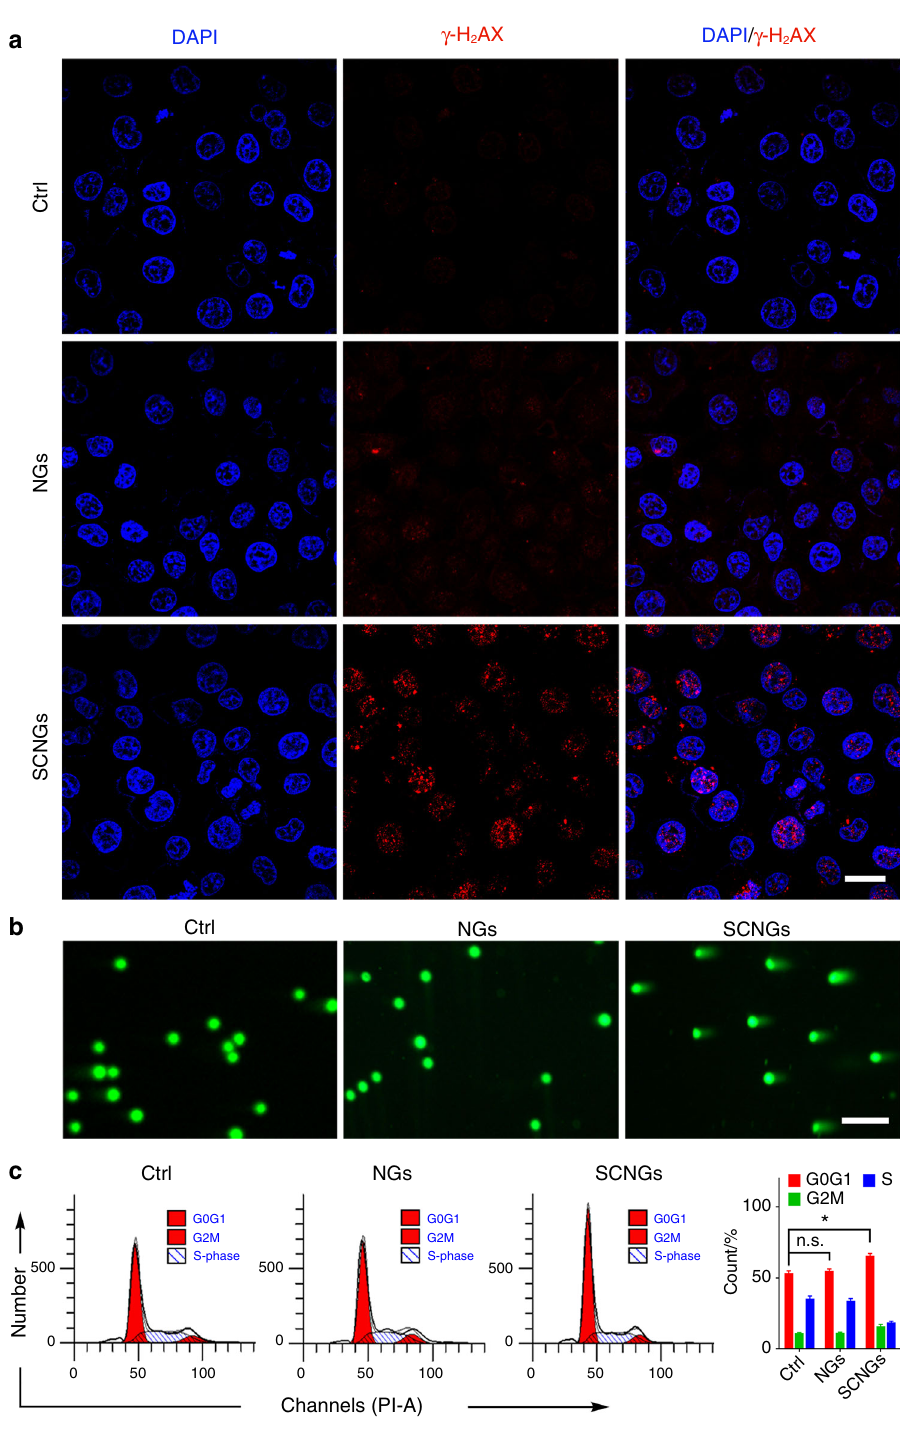
Fig. 5 Mechanism of tumour cell apoptosis induced by EDT. a Representative CLSM images of different groups of HepG2 cells using γ H2AX as a DNA damage biomarker. Scale bar, 20 µ m. The red fl uorescence indicates the DNA damage of HepG2 cells caused by 1 O 2 after SCMGs treatment. b Representative fl uorescent images of DNA damages in different groups of HepG2 cells using the neutral comet assays. Scale bars, 50 μ m. The appearance of longer comet tails in HepG2 cells indicates the damaged DNA doubles-strand breaks. c Effects of SCNGs on cell cycles by fl ow cytometry assays on different groups of HepG2 cells with PI staining (left), and the corresponding data analysis (right). The control, NGs and SCNGs groups are referring to the HepG2 cells after incubation with PBS, NGs and SCNGs respectively at the IC 50 value for 24 h. The all experiments were performed three times, and the representative results are displayed. Data are presented as mean ± s.d. ( n = 3). p values were analyzed by Student ’ s two-sided t -test (* P < 0.05, n.s. represents no signi fi cant differences). Source data are provided as a Source Data fi